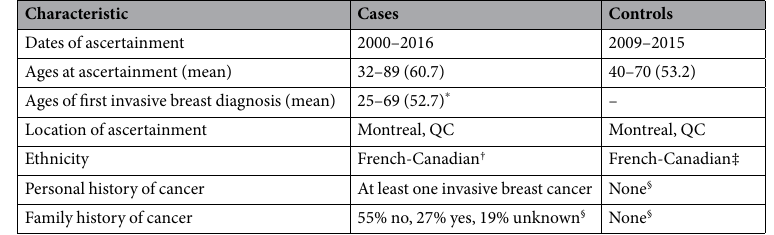
Table 4. Summary of cases and controls series for French-Canadian BRCA1/2/PALB2 genotyping. * Intervals between ages at first invasive breast cancer and ascertainment range from 0 to 11 years (Mean = 0.67, S.D. = 5.36). † As determined by a review of last names. ‡ As determined by French first language, Canadian origin of all four grandparents, and a city of birth located in Quebec. § Self-reported